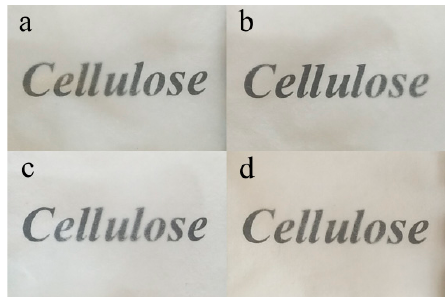
Figure 3. Photograph of specimens prepared by AM: ( a ) RWSC; ( b ) 0.1% CNFs; ( c ) 1.5% CNFs; ( d ) 3.0% CNFs.